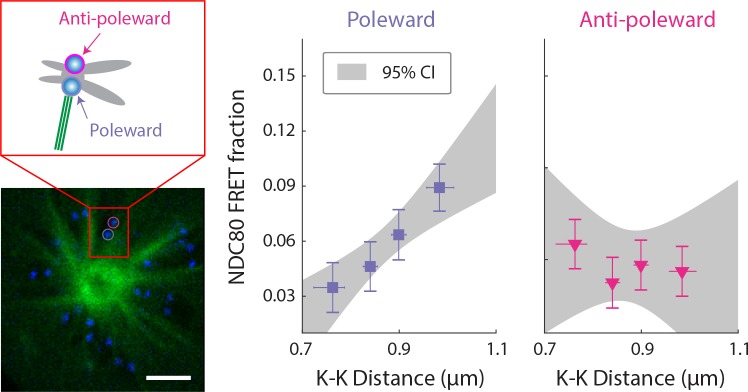
NDC80 FRET fraction of poleward- and anti-poleward-facing kinetochores in STLC-treated cells with monopolar spindles.NDC80 FRET fraction vs. K-K distance for poleward-facing kinetochores (purple square, same as Figure 3D) and anti-poleward-facing kinetochores (pink triangles) in cells treated with 5 μM STLC (n = 16 cells, 493 kinetochores/data point). Data points are the mean, y-error bars the SEM, and the x-error bars the interquartile ranges within groups of kinetochores with similar K-K distances. 3 µm scale bar. Gray area is the 95% confidence interval for the linear fit.